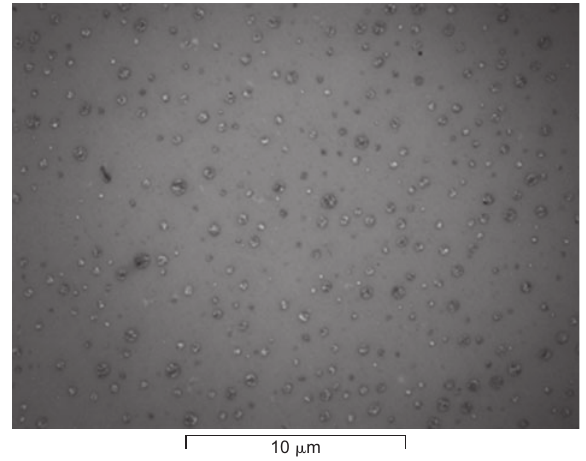
Figure 6 TEM picture from RTM6 ® + 5 wt % MAM.